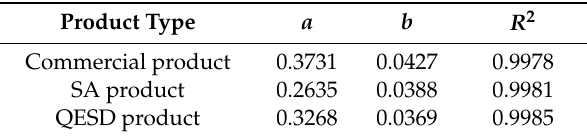
Table 2. Parameters of packability of the commercial and spherical